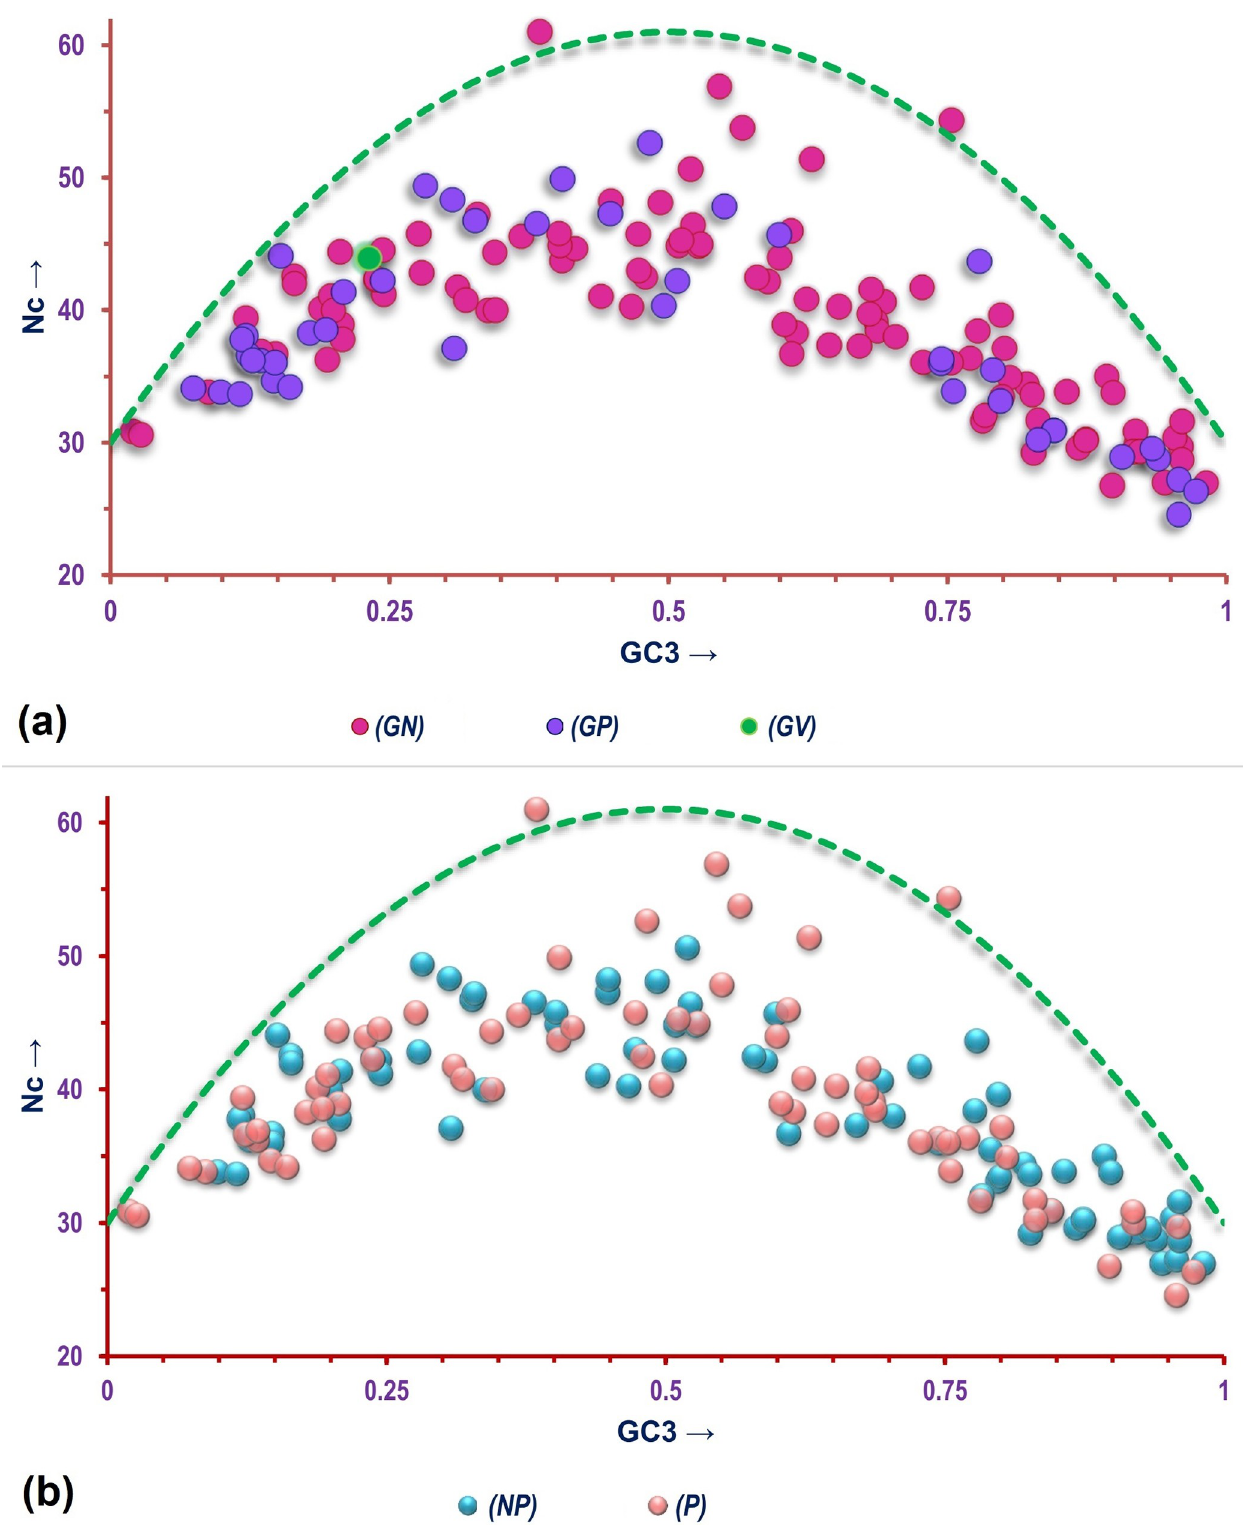
Fig 2. Nc-plots depicting the correlation between Nc and GC3 of the 143 ftsZ CDS selected for this study based on Gram nature and lifestyle. (a) Nc- plot constructed by demarcating the ftsZ CDS on the basis of Gram nature where GP = CDS of Gram positive bacterial species, GN = CDS of Gram negative